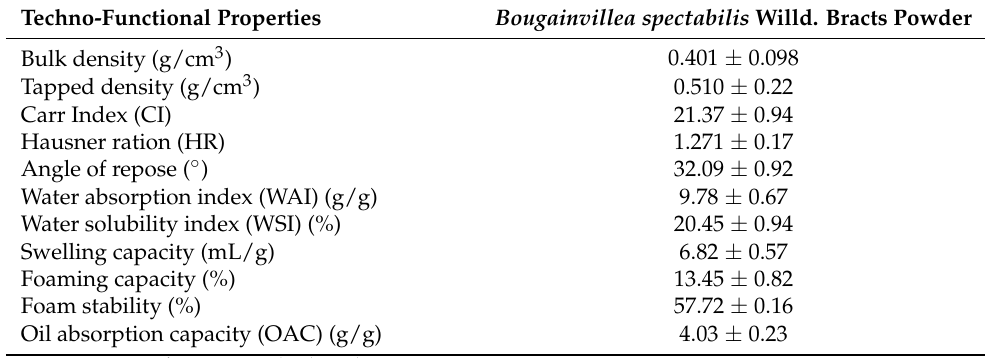
Table 1. Techno-functional properties of dried Bougainvillea spectabilis Willd. bracts powder. Techno-Functional